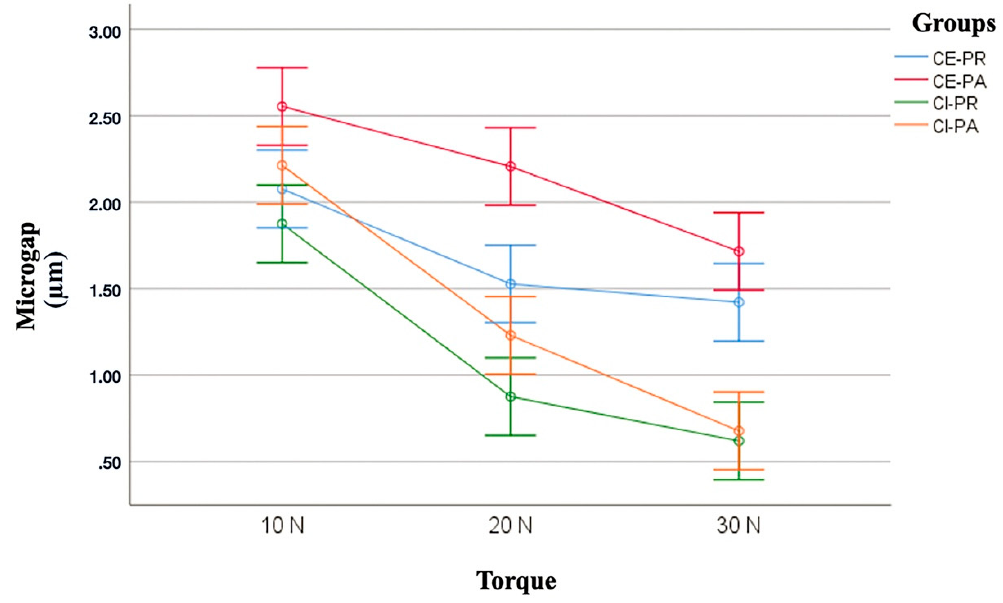
Figure 4. Box plot of misfit values ( µ m) among the groups according to the applied torque.